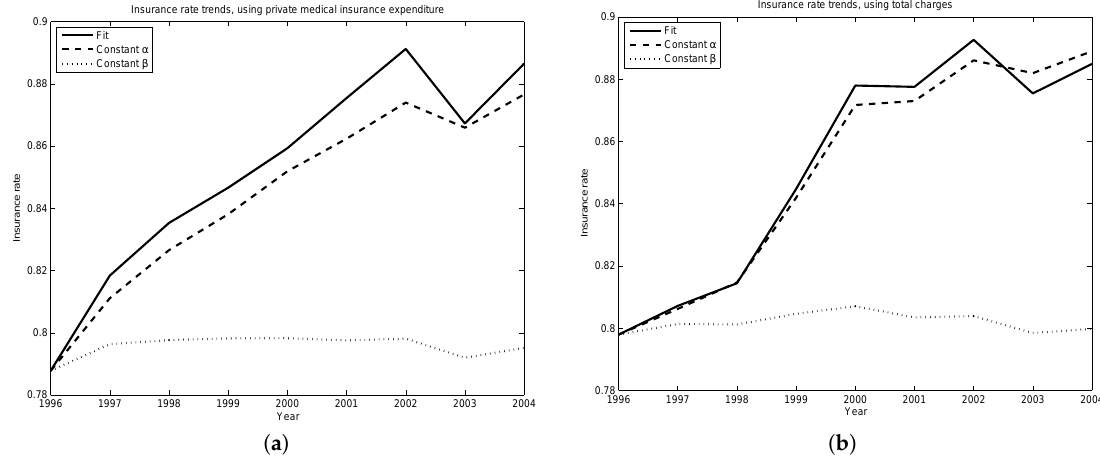
Figure 5. Changes in levels dominate changes in